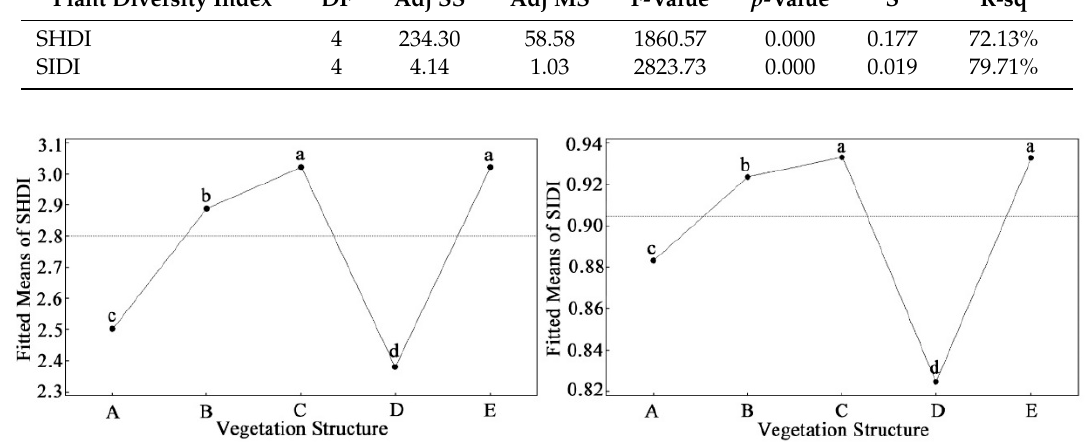
Table 8. Linear regression analysis of plant diversity index and atmospheric suspended particulate matter concentration. Plant Diversity Index